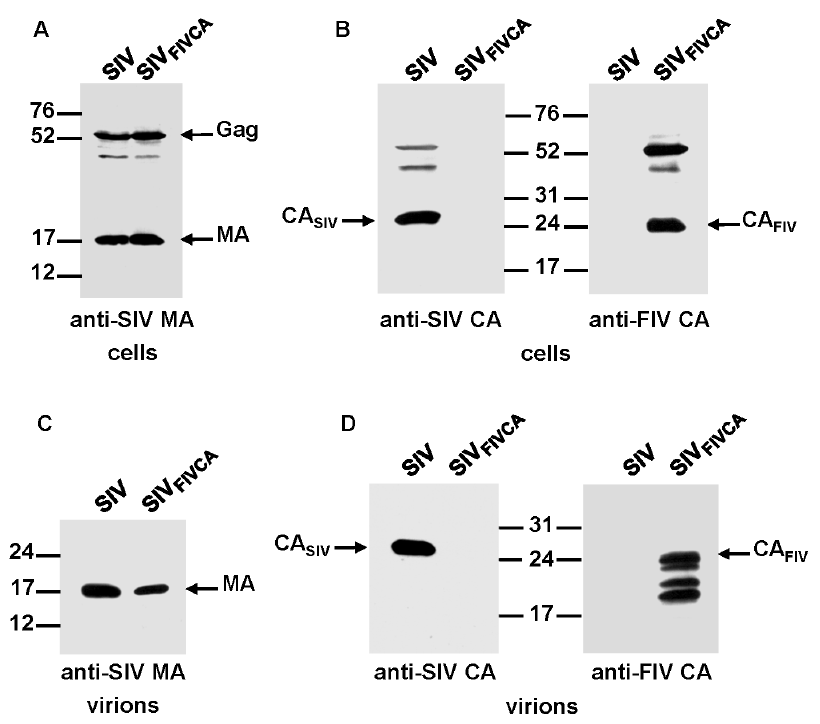
Figure 2. Assembly phenotype of the chimeric SIV FIV CA virus. 293Tcells were transfected in parallel with the wild-type SIV SMM-PBj and SIV FIV CA proviral DNAs. At 48 h post-transfection, cell and virion lysates were resolved on SDS-polyacrylamide gels, transferred to nitrocellulose membranes and detected with antibodies specific for the SIV MA (A and C) and for the SIVand FIV CA proteins (B and D). The positions of the wild-type and chimeric Gag proteins as well as those of the MA and CA proteins are shown. Numbers refer to the positions of the molecular weight standards (in kDa).